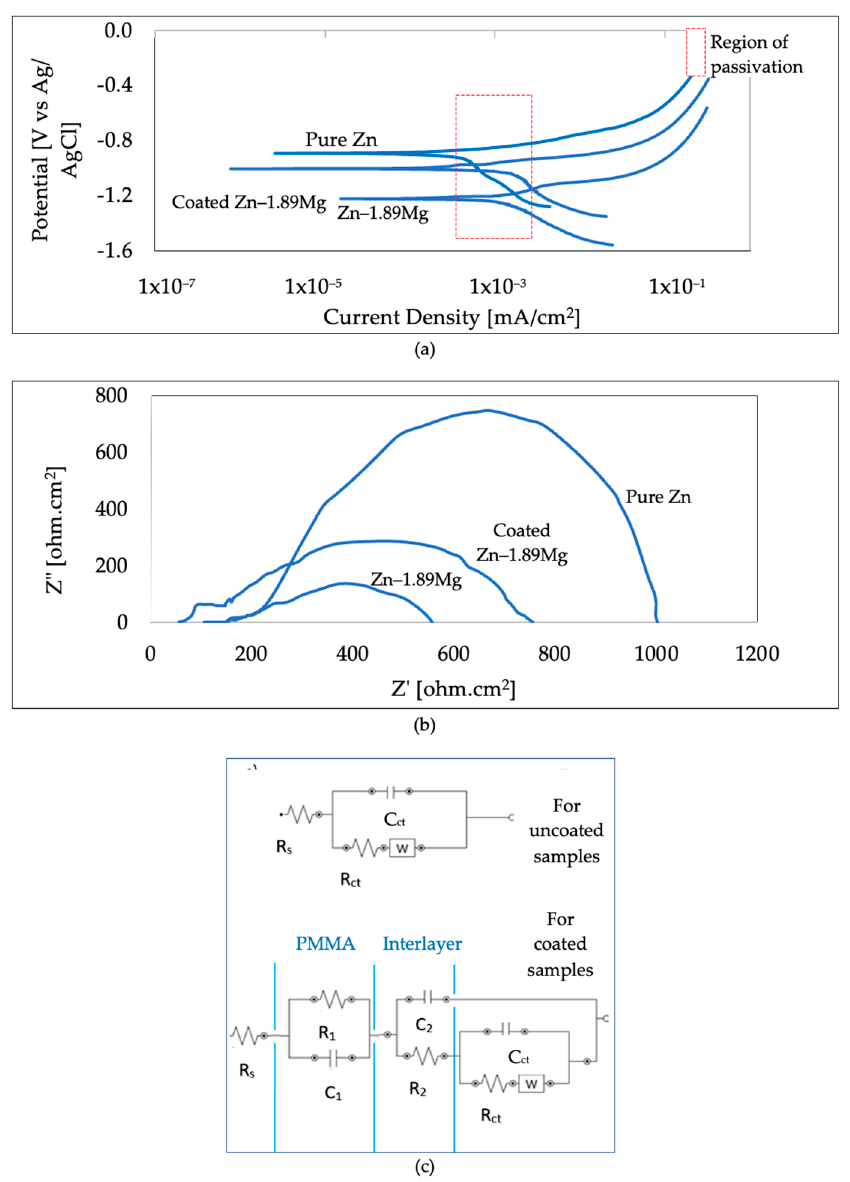
Figure 6. The electrochemical corrosion measurements of studied samples: ( a ) polarization curves; ( b ) Nyquist plots; ( c ) schematic representation of the used equivalent circuit.